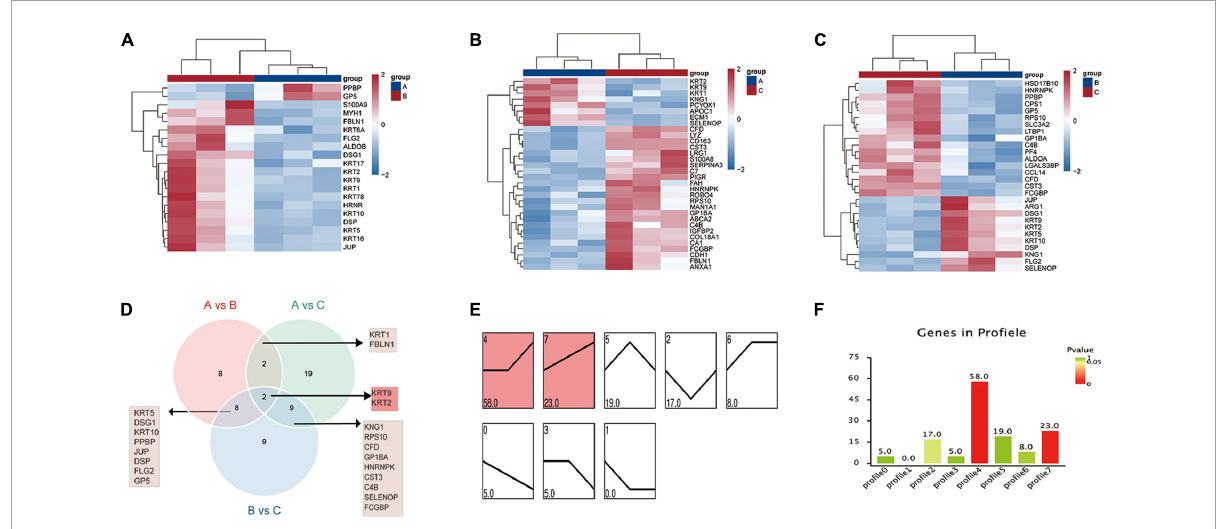
FIGURE5 Protein expression patterns in healthy control, HZ, and PHZ groups. (A–C) The heatmap of differential expressed proteins (DEPs) between groups: (A) Group A vs. B, (B) group A vs. C, (C) group B vs. C. (D) Identification of significant common proteins via Venn diagram; (E) trend expression profile of proteins among three groups; (F) number of proteins in the profile. The height of the column represents the number of proteins, and the color of the column represents the P